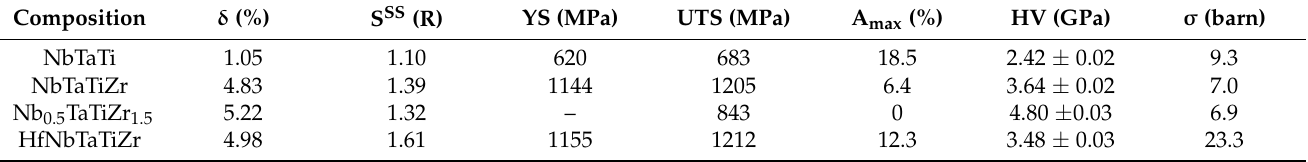
Table 4. List of refractory metal alloys studied in the present work. The table shows the composition of each alloy, atom misfit parameter ( δ ) representing a measure of the magnitude of lattice distortions, configurational entropy of a random solid solution (S SS ), results of a tensile test with a constant strain rate of 2 × 10 –4 s –1 [80]: yield strength (YS), ultimate tensile strength (UTS), and elongation-to-failure (A max ). Vickers hardness (HV) measured using a load of 0.5 kg applied for 10 s, and the average cross-section for absorption of epithermal neutrons ( σ ).